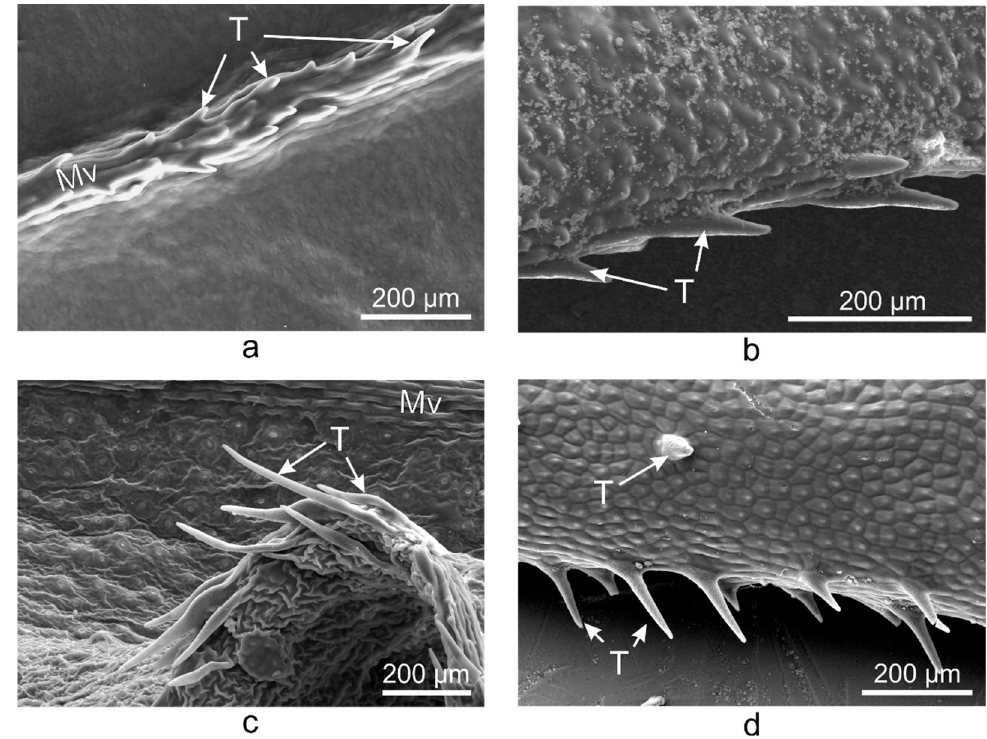
Figure 3. SEM micrographs showing the trichomes present on the midvein of V. minor leaf ( a ) and the marginal trichomes on the leaves of V. major ( b ), V. major var. variegata ( c ), and V. herbacea ( d ), all oriented towards the apex of the leaf; Mv—midvein, T—trichome.